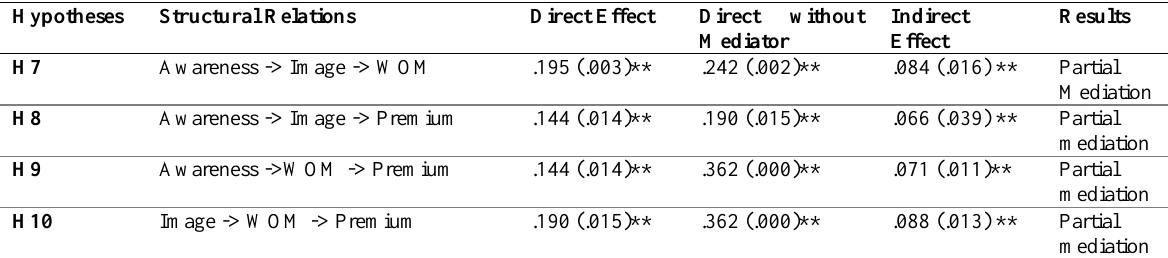
Table 7: Results of Mediation